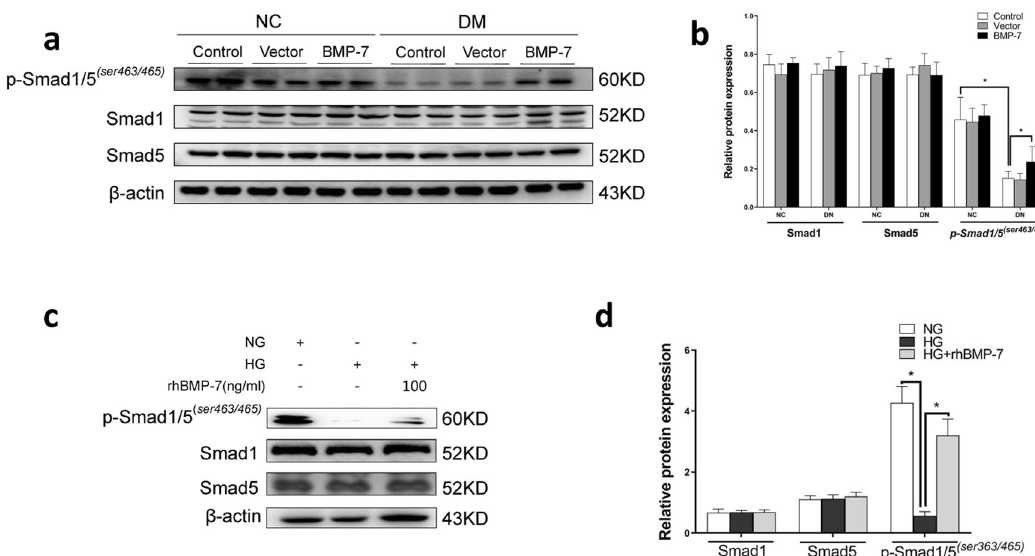
Fig. 5 BMP-7 preserved the activity of p-Smad1/5 in vivo and in vitro. a Western blotting and b quantitative data represent the expressions of p-Smad1/5 (ser463/465) , Smad1, and Smad5 in the kidney tissues in different groups, * P < 0.05 ( n = 6). c Western blot and d quantitative data represent the expressions of p-Smad1/5 (ser463/465) , Smad1, and Smad5 in NRK-52E cells under different conditions, * P < 0.05 ( n =